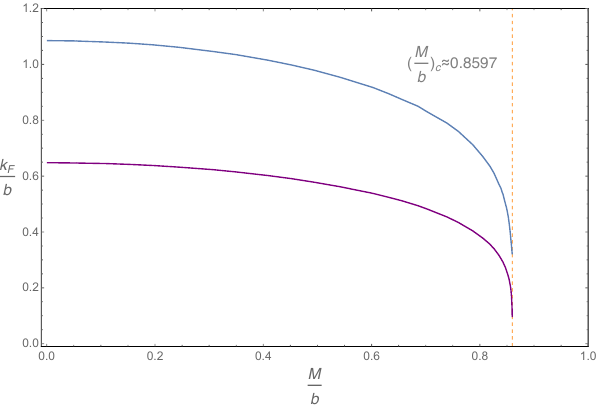
Figure 5 . The linear dispersion around one of the multiple Fermi surfaces at k F /b = 1 . 085 for M ’ 0 . 0014 . b